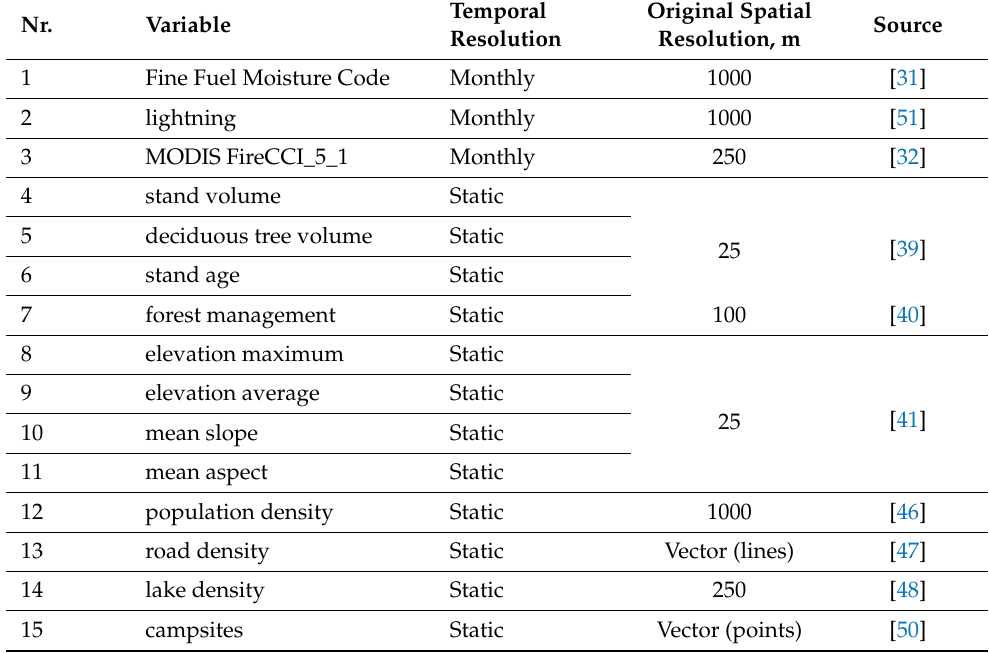
Table 1. Modeling variable